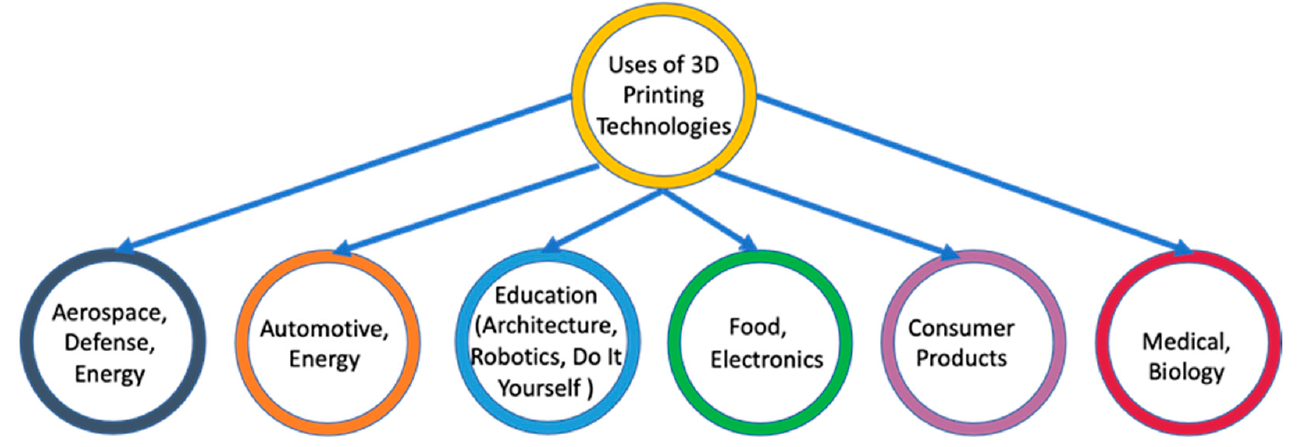
Figure 8. Application of 3D printing technologies .